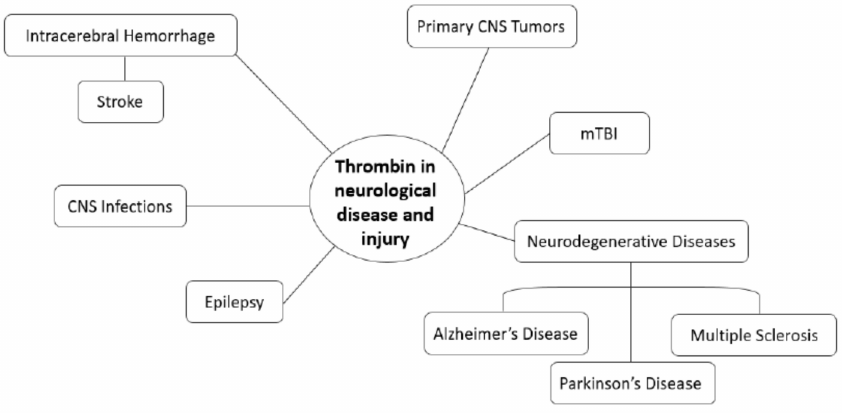
Figure 1. Relevance of thrombin to neurological disease and injury. The role of thrombin in epilepsy, CNS infections, mild traumatic brain injury, neurodegenerative diseases, stroke, and primary CNS tumors continues to be